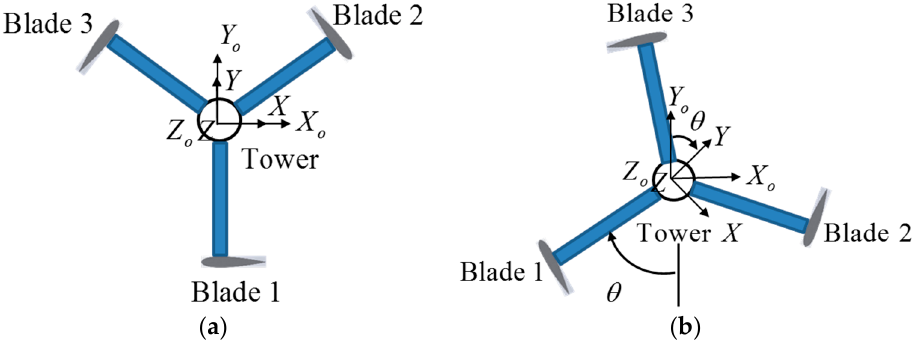
Figure 10. Rotating and reference frames: ( a ) At the azimuth of 0°; ( b ) At the azimuth of θ .